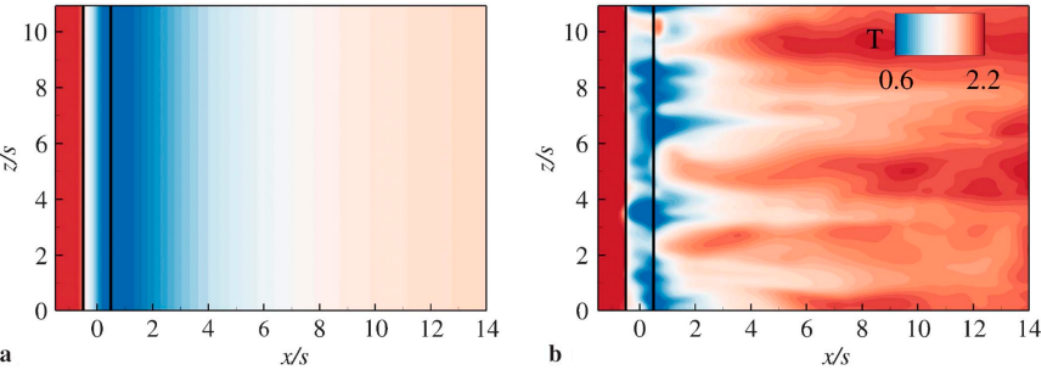
Figure 4. Slot film pattern for ( a ) laminar and ( b ) turbulent flow indicates that film is not really a uniform coverage, but rather forms streaks even if the injection source is a slot. [17]. The plot shows local wall temperatures, blue being cooler than red.